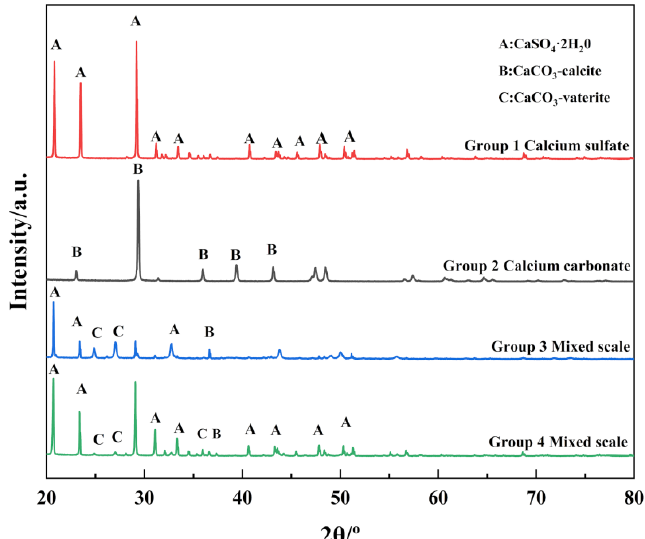
Figure 7. The XRD patterns of sediments, and the sediments from each group have been dried at 45 °C for 24 h